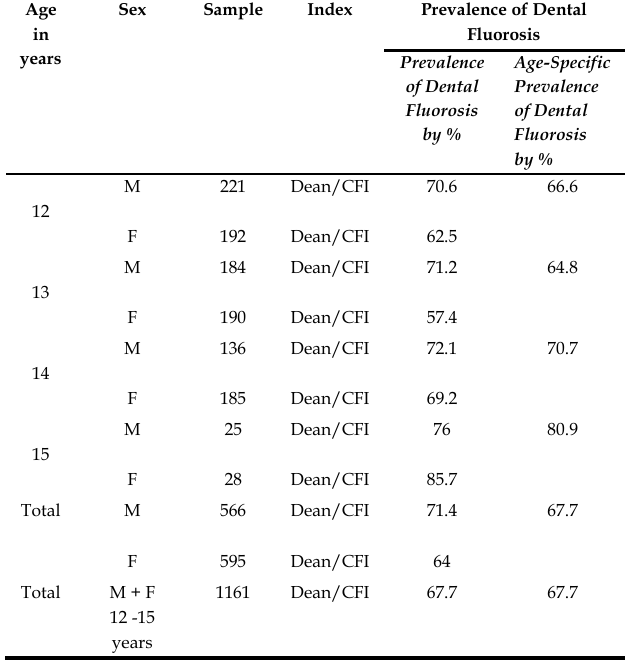
Table 2: Prevalence and community fluorosis index of the urban studied population